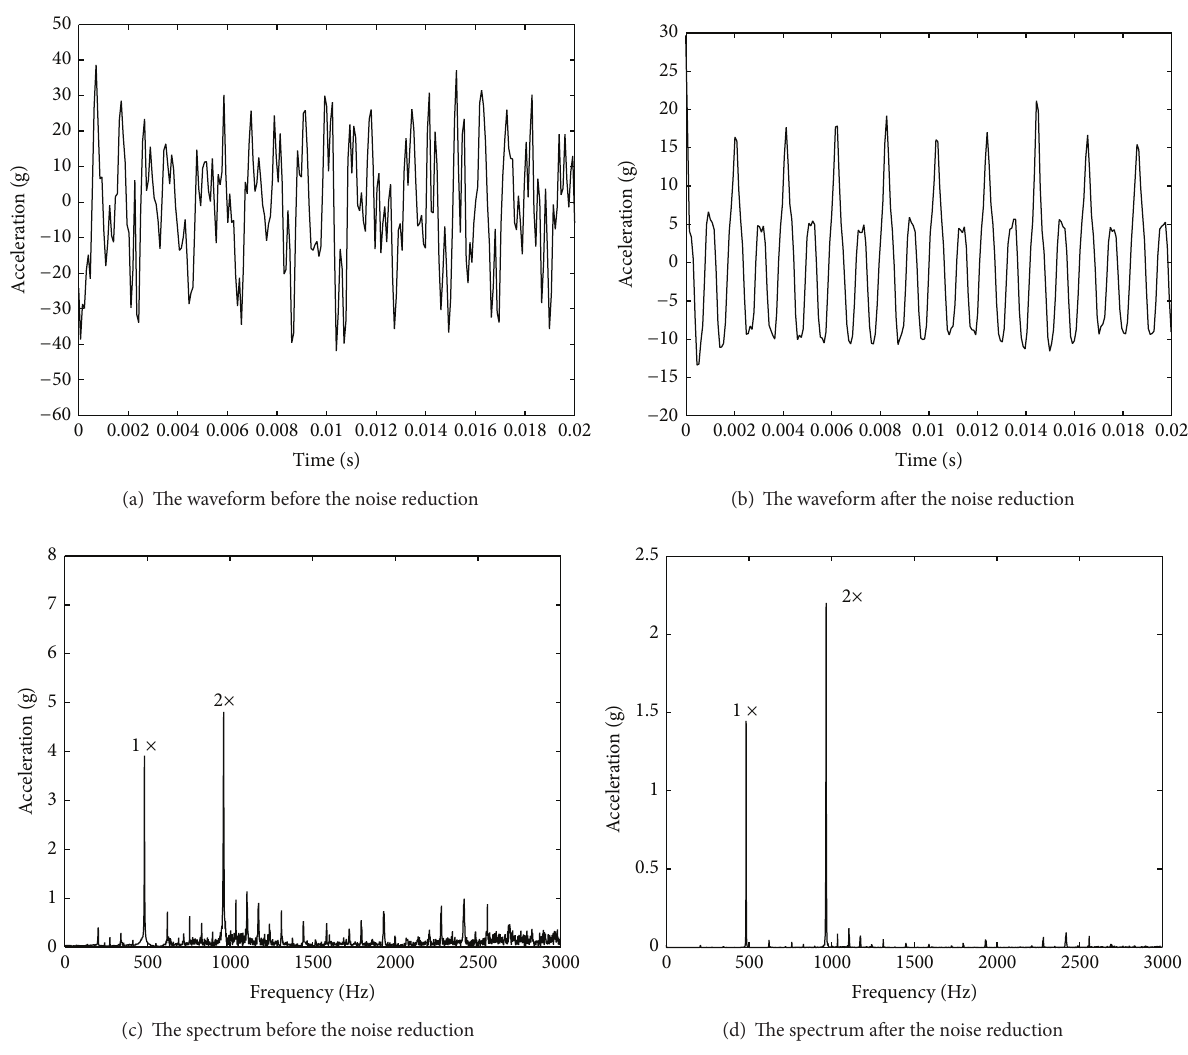
Figure 21: The time domain waveform and frequency spectrum before and after the noise reduction when the rotating speed is 29000 rpm.